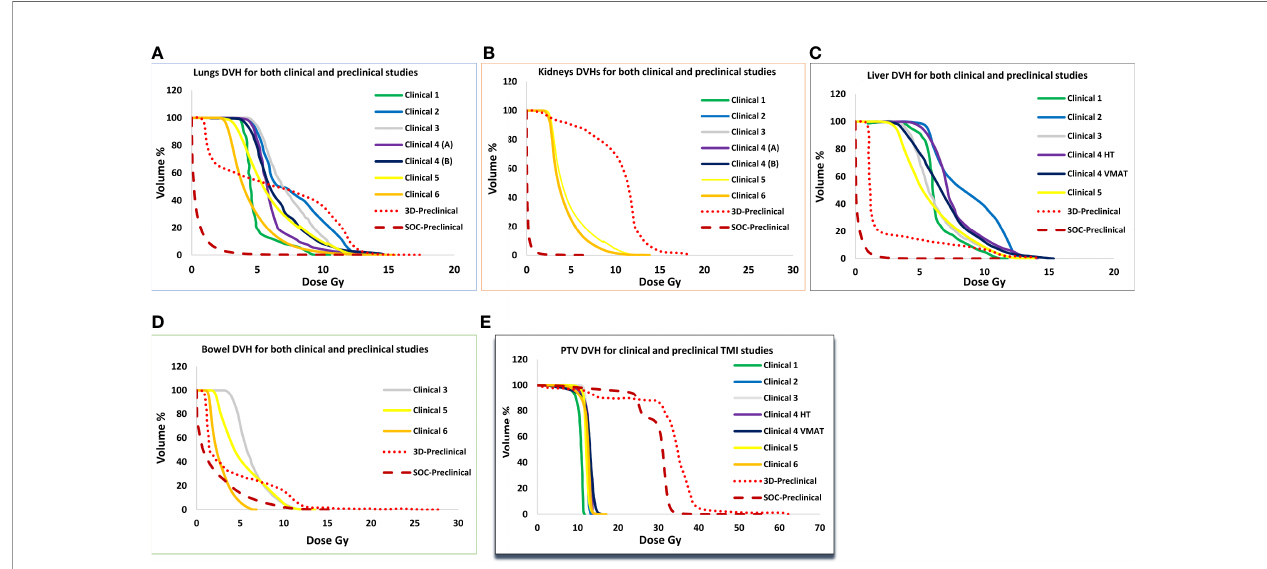
FIGURE 4 | Comparison of average dose volume histograms (DVH) for the (A) lungs, (B) kidneys, (C) liver, (D) bowel, and (E) PTV between six clinical TMI plans, 3D-preclinical model (red dotted lines), and the SOC-preclinical TMI model (dark red dashed